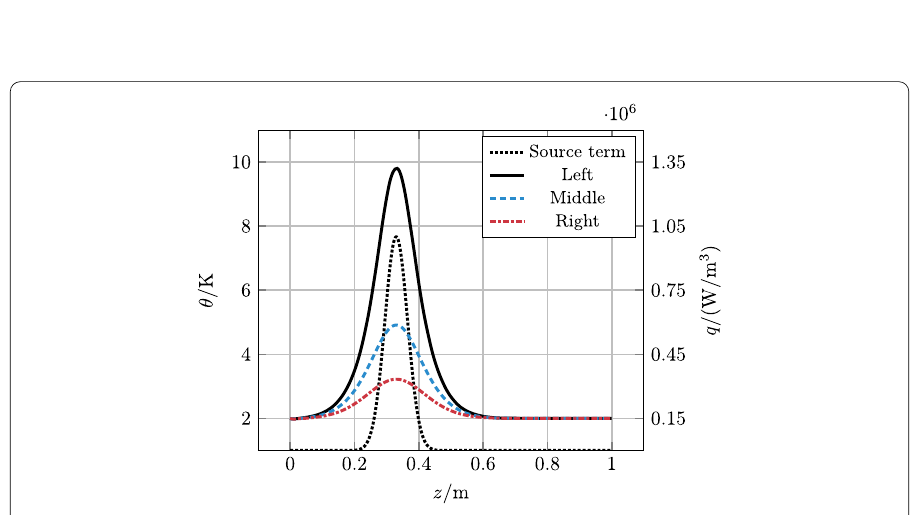
Figure 7 Temperature distribution in z -direction in the three cables at time t = 10 ms and the source term in dependency of z . The temperature of the cables is evaluated in the center of their cross-section